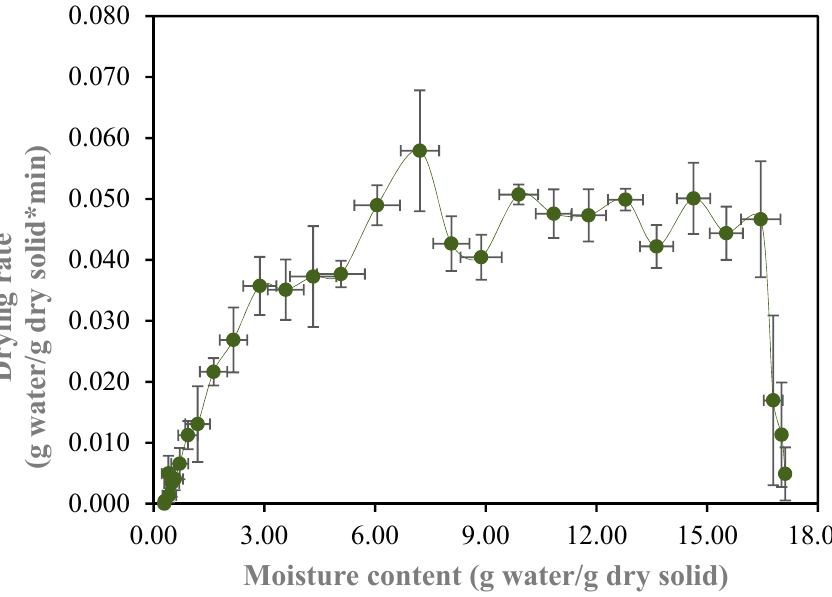
Figure 3. Drying rate versus moisture content from mean values of the two drying chambers (n = 3).